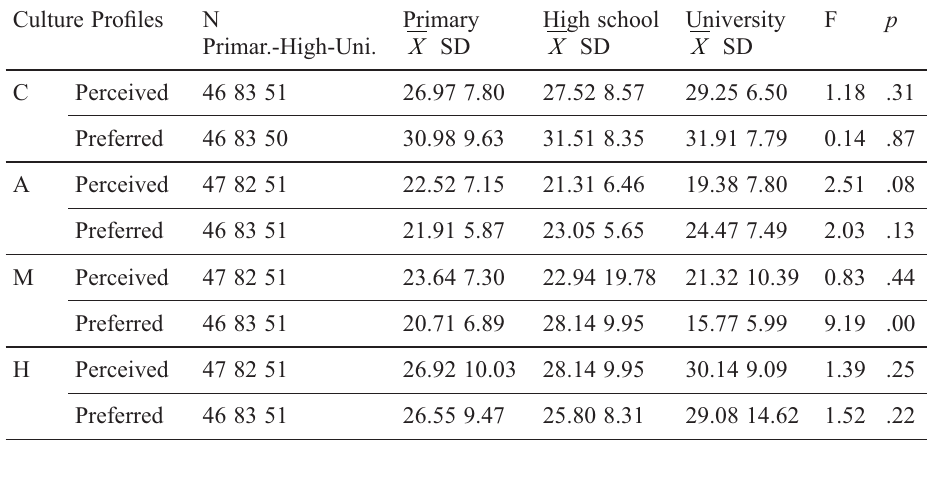
Table 4. Means, standart deviations, t and p values of culture profi les due to education level Culture Profi